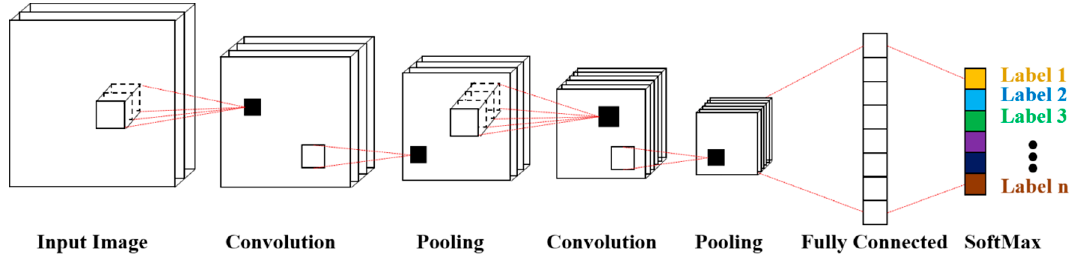
Figure 2. Convolutional neural network for scene classification.